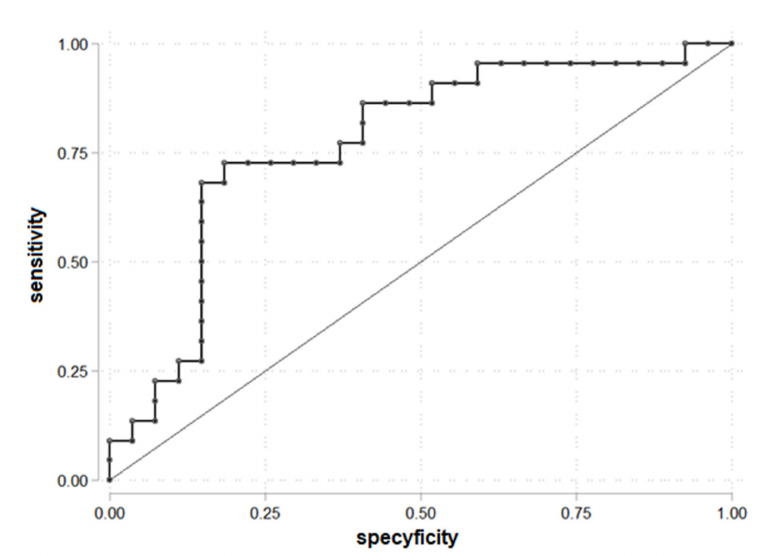
Figure 2. ROC curve for prediction PDFF > 5.56% according to the FAI ( n = 49). Table 4. The number of patients with liver steatosis depending on FAI.